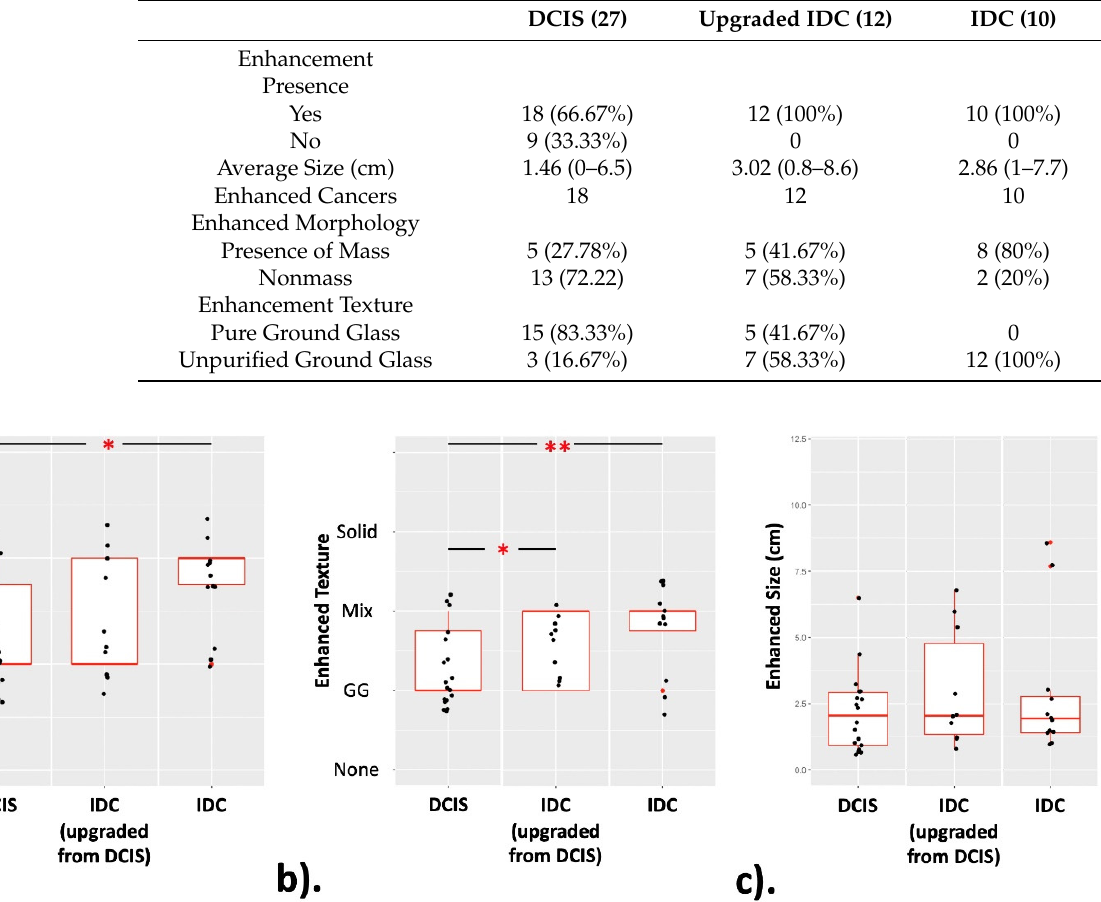
Figure 3. The box plots of three lesion groups. These demonstrate the distribution of ( a ) enhanced morphology, ( b ) en- texture and ( c ) enhanced size, among three groups. (*: p < 0.05; **: p < hanced texture and ( c ) enhanced size, among three groups. (*: p < 0.05; **: p < 0.01).